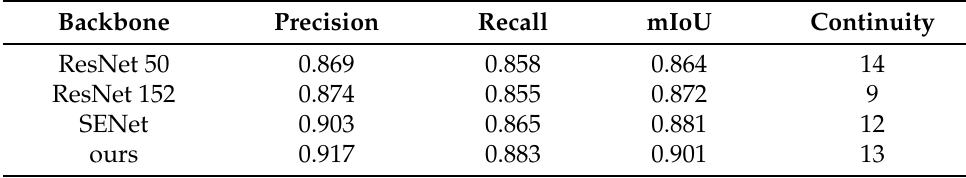
Table 10. Comparison results of backbone feature extraction